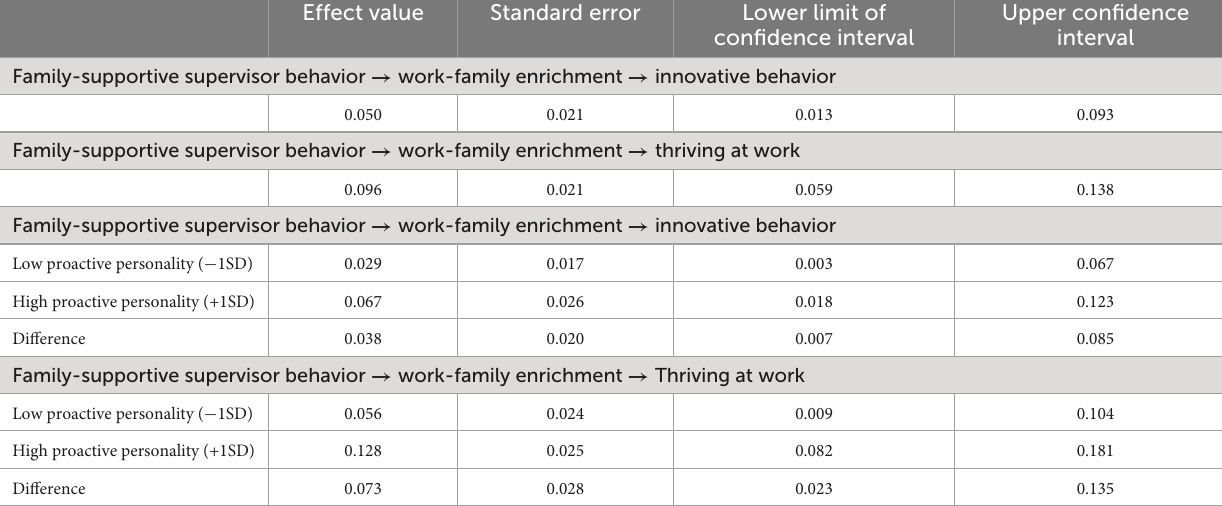
TABLE 7 Bootstrap results for mediating effects and mediated effects with